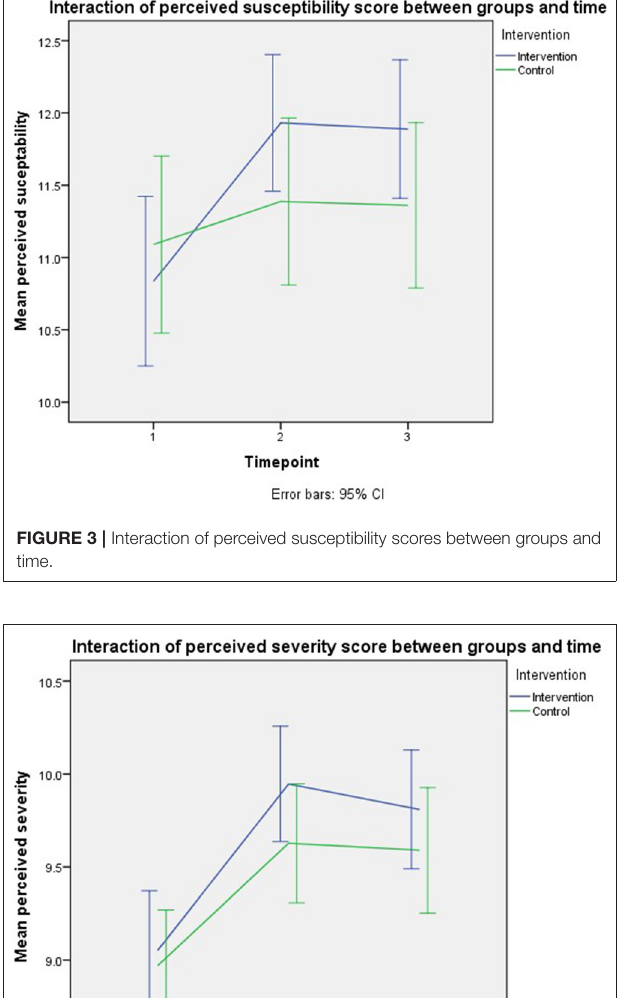
included in the multivariate analysis. It was not significantly significantly change the model goodness of fit, QIC.